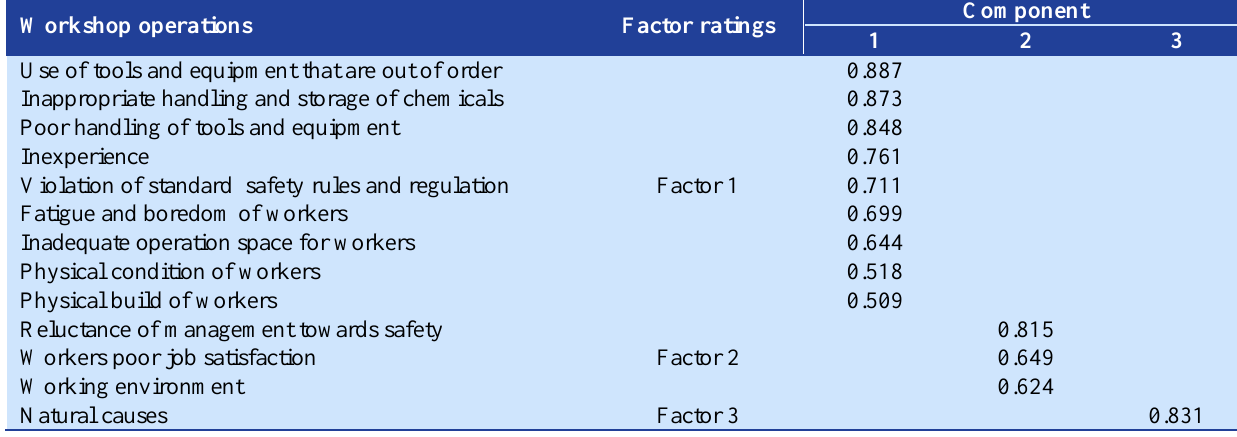
Table 5. Rotated component matrix for workshop operations Workshop